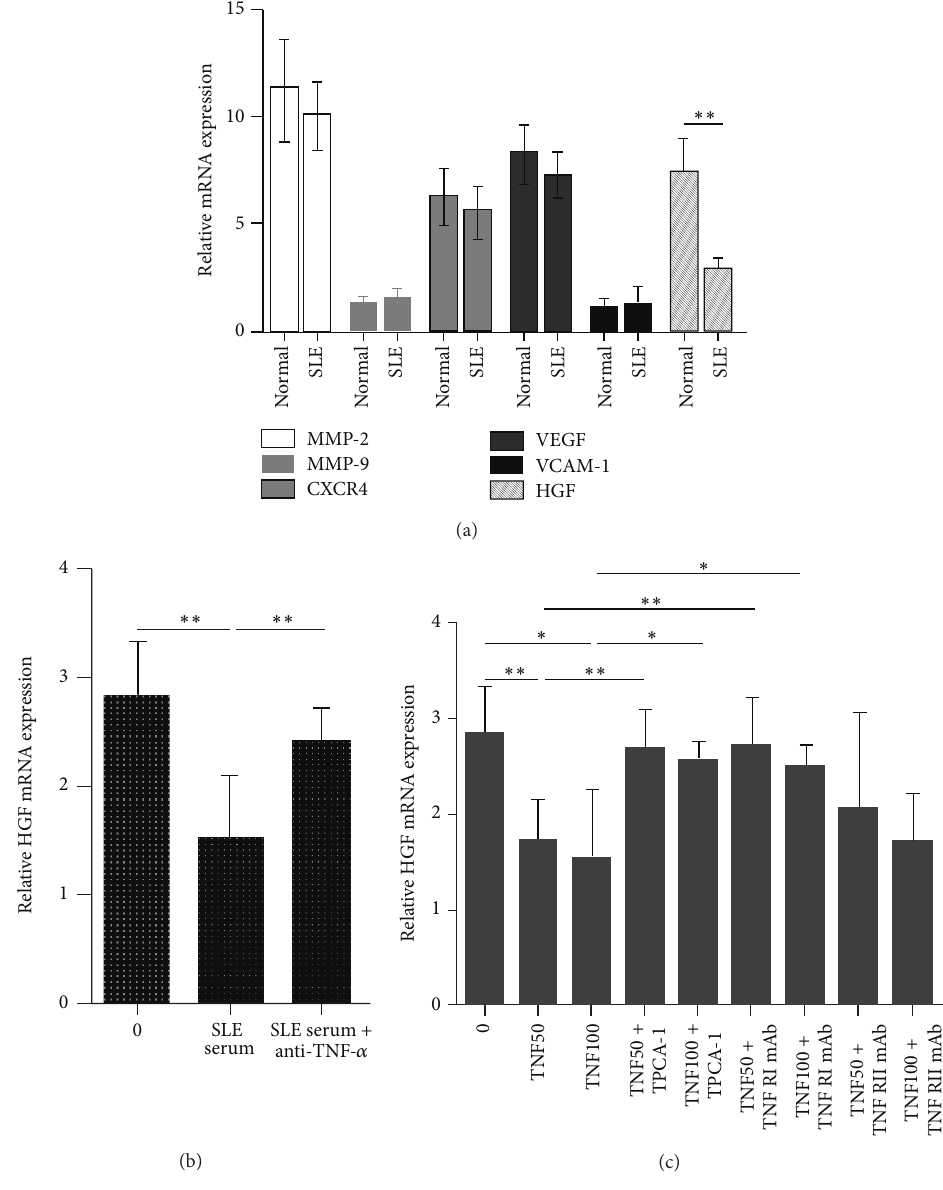
Figure 6: TNF- 𝛼 and IKK- 𝛽 regulated SLE BMSCs migration through the inhibition of HGF production. (a) Level of HGF mRNA, instead of MMP-2, MMP-9, CXCR4, VEGF, and VCAM-1, was decreased in SLE BMSCs compared with normal BMSCs. (b) HGF expression in SLE BMSCs was downregulated by SLE serum, which was abrogated with the addition of anti-TNF- 𝛼 mAb. (c) HGF mRNA level in SLE BMSCs pretreated with recombinant human TNF- 𝛼 with the presence or absence of anti-TNFRI mAb, anti-TNFRII mAb, or TPCA-1 ( 𝑛 = 3 ). TNF50: TNF- 𝛼 : 50 𝜇 g/L; TNF100: TNF- 𝛼 : 100 𝜇 g/L. ∗ 𝑃 < 0.05 ; ∗∗ 𝑃 < 0.01